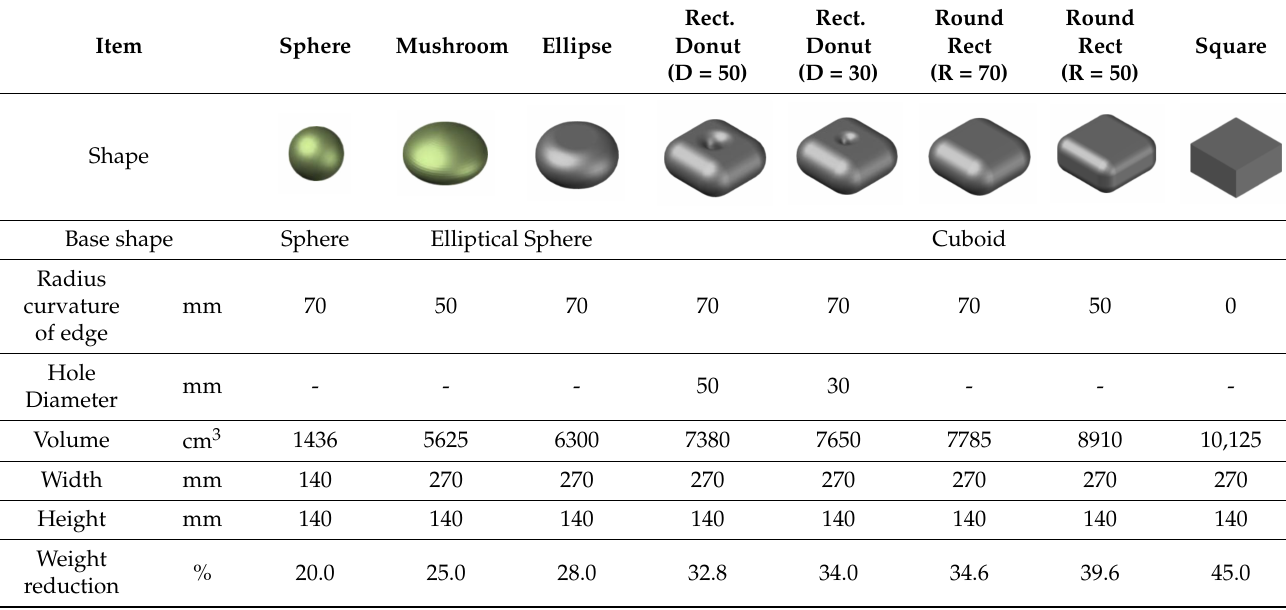
Table 2. Properties of the void shaper for the FE analysis